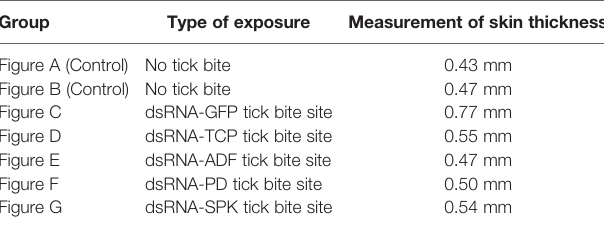
TABLE 3 | Measurements of rabbit skin thickness indicating the extent of oedema at the tick bite site relative to the control (no tick bite). Group Type of exposure Measurement of skin thickness Figure A (Control) No tick